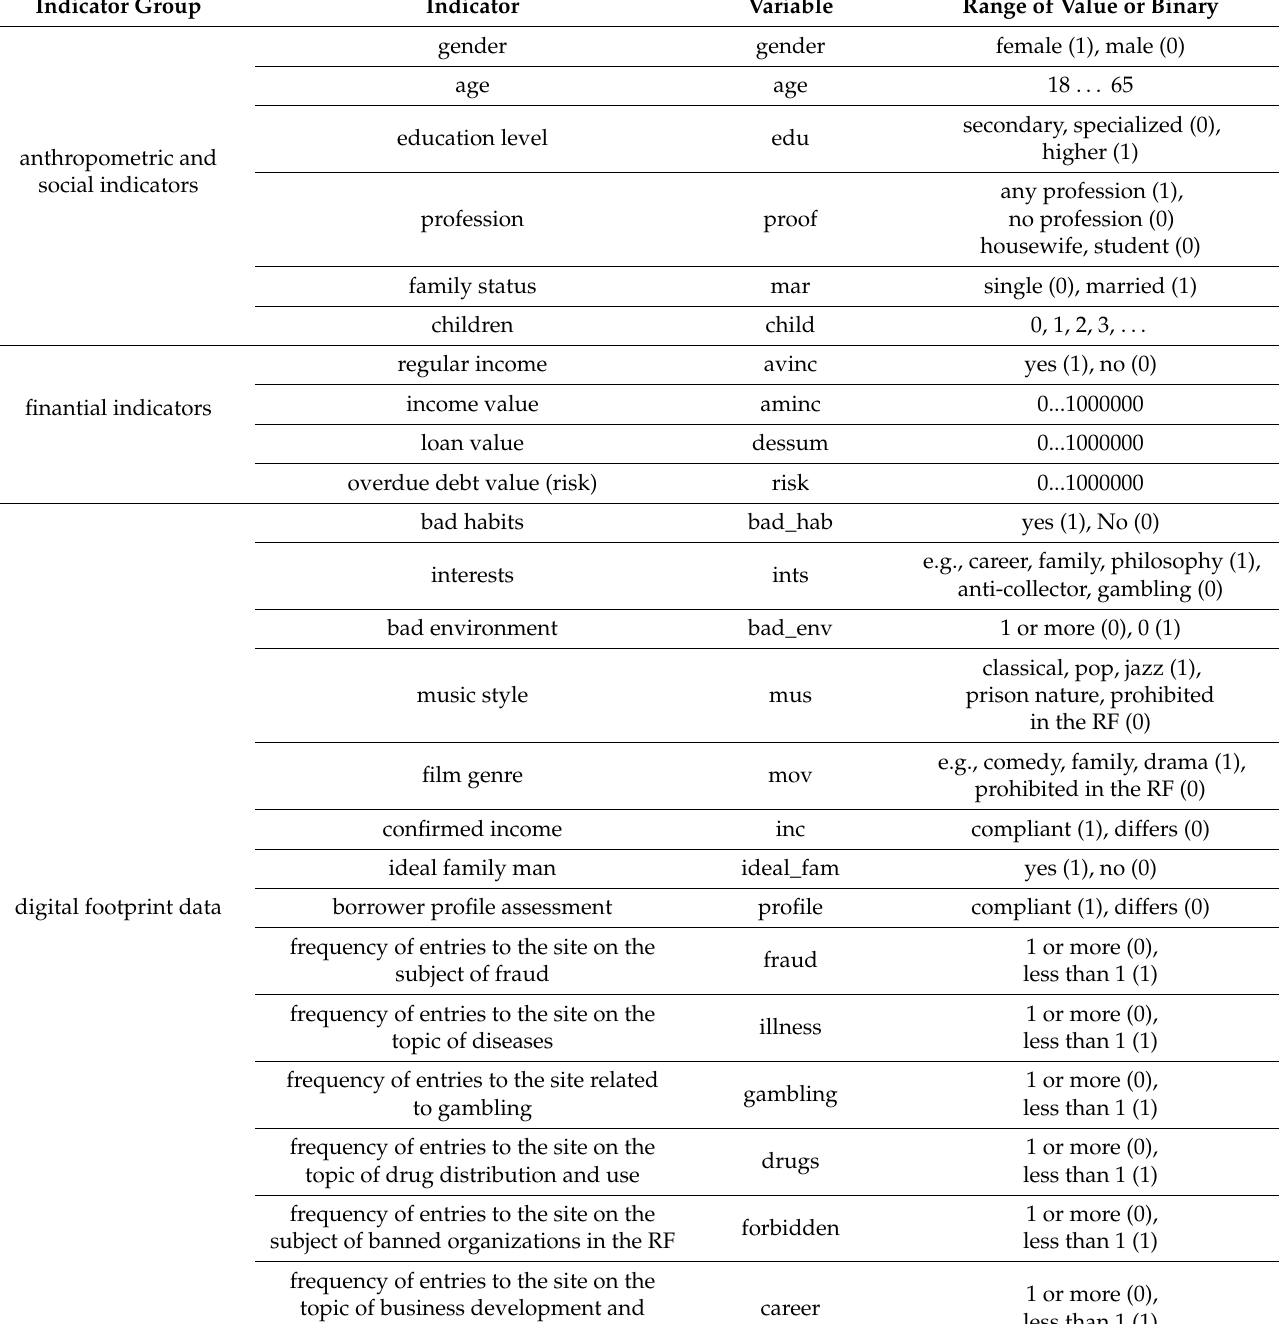
Table 1. Investigated indicators, designations, and range of